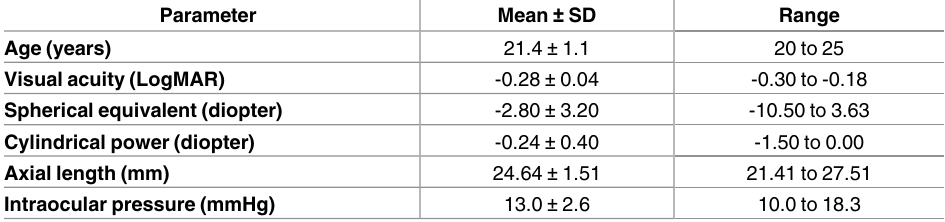
Table 1. Participant Demographic and Ocular